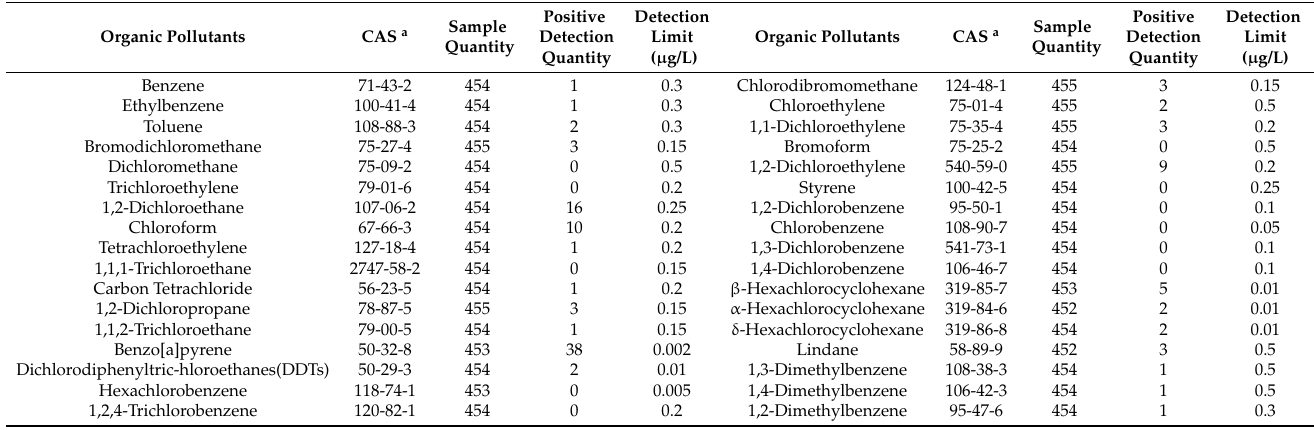
Table 1. Statistics of organic pollutants in groundwater from the Junggar